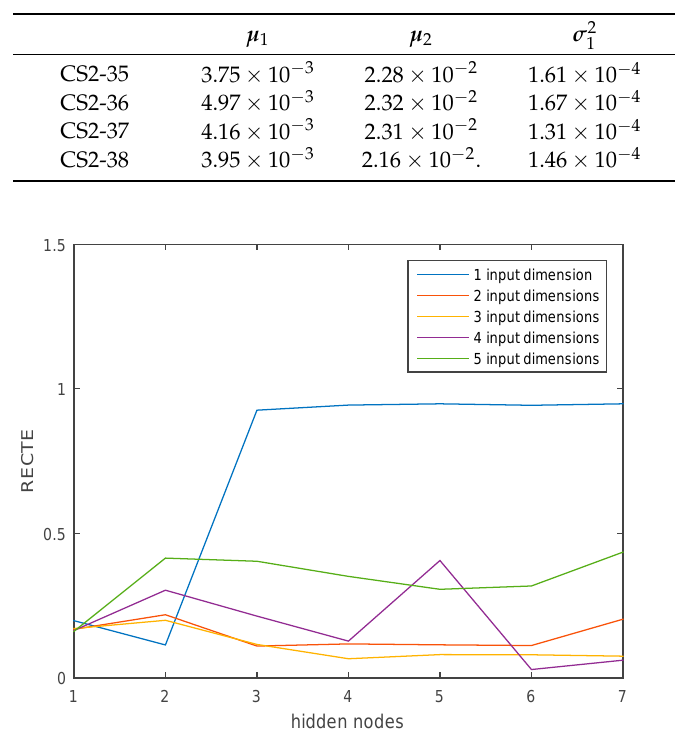
Figure 8. Random items of CS2-35 ( a ), CS2-36 ( b ), CS2-37 ( c ), and CS2-38 ( d ). Table 2. Offline parameter estimates of CS2-35, CS2-36, CS2-37, and CS2-38.